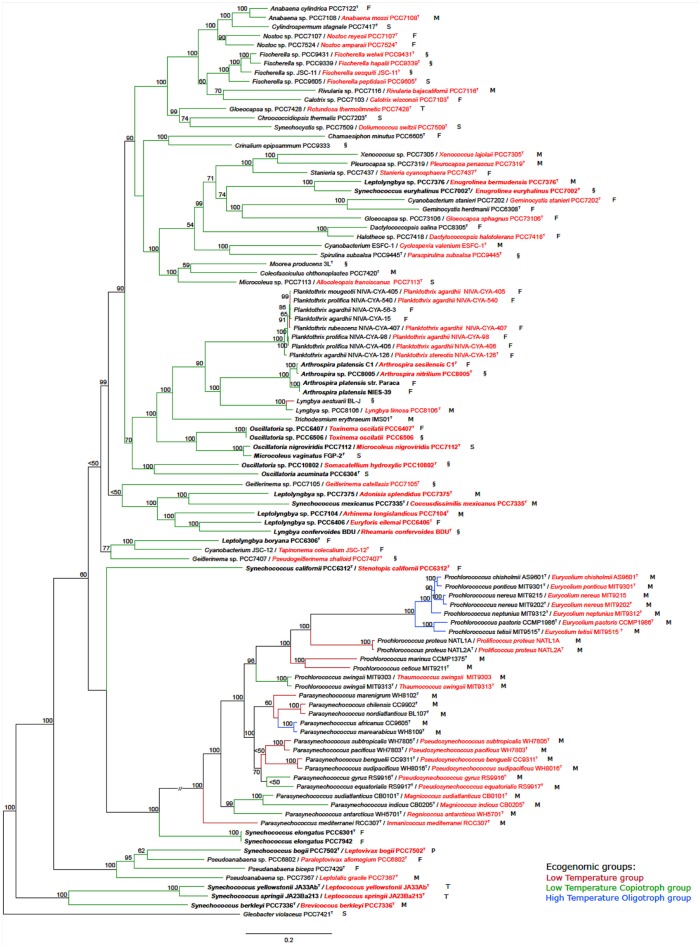
Phylogenomic tree of the Cyanobacteria phylum with the proposed new names. Tree construction was performed using 100 genomes (ninety-nine used in this study plus the outgroup), based on a set of conserved marker genes. The numbers at the nodes indicate bootstrap values as percentages greater than 50%. Bootstrap tests were conducted with 1,000 replicates. The unit of measure for the scale bars is the number of nucleotide substitutions per site. The Gloeobacter violaceus PCC 7421 sequence was designated as outgroup. Capital letters indicate environmental source: F, freshwater; M, marine; P, peat bog (sphagnum); S, soil; T, thermal; and §, other habitat. New names are highlighted in red. Overwritten T indicates type strain or type species. Ecogenomic groups are depicted in different colors as indicated in the legend: Low Temperature group; Low Temperature Copiotroph group; and High Temperature Oligotroph group. Cases depicted in the Results section are in bold.